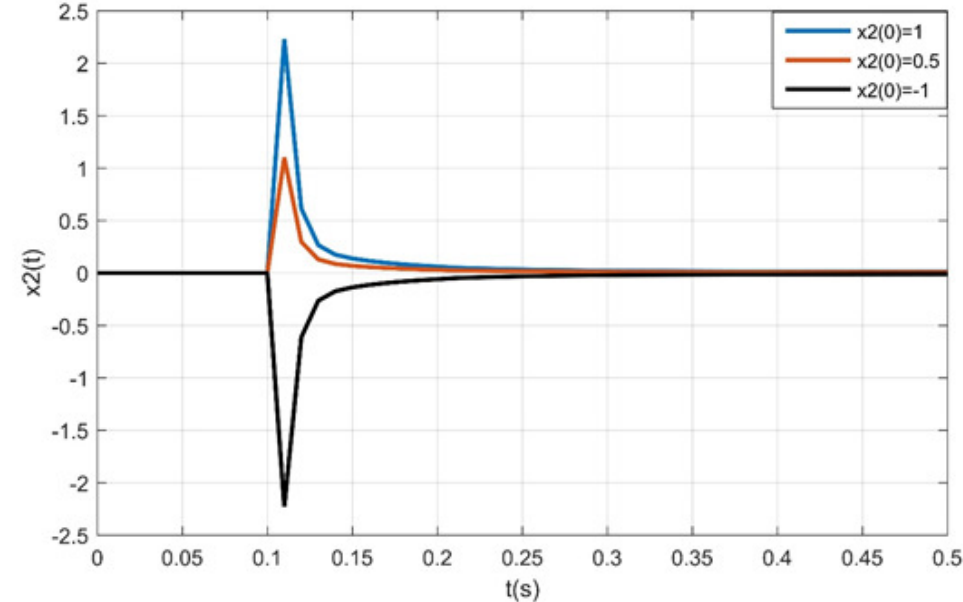
Figure 2. The behaviors of uniformly, asymptotically and Mittag–Leffler stable solution x 2 ( t ) of the system of of FrRIDEs in Equation (11) for q = 0.5, τ = 1 t ≥ 1 10